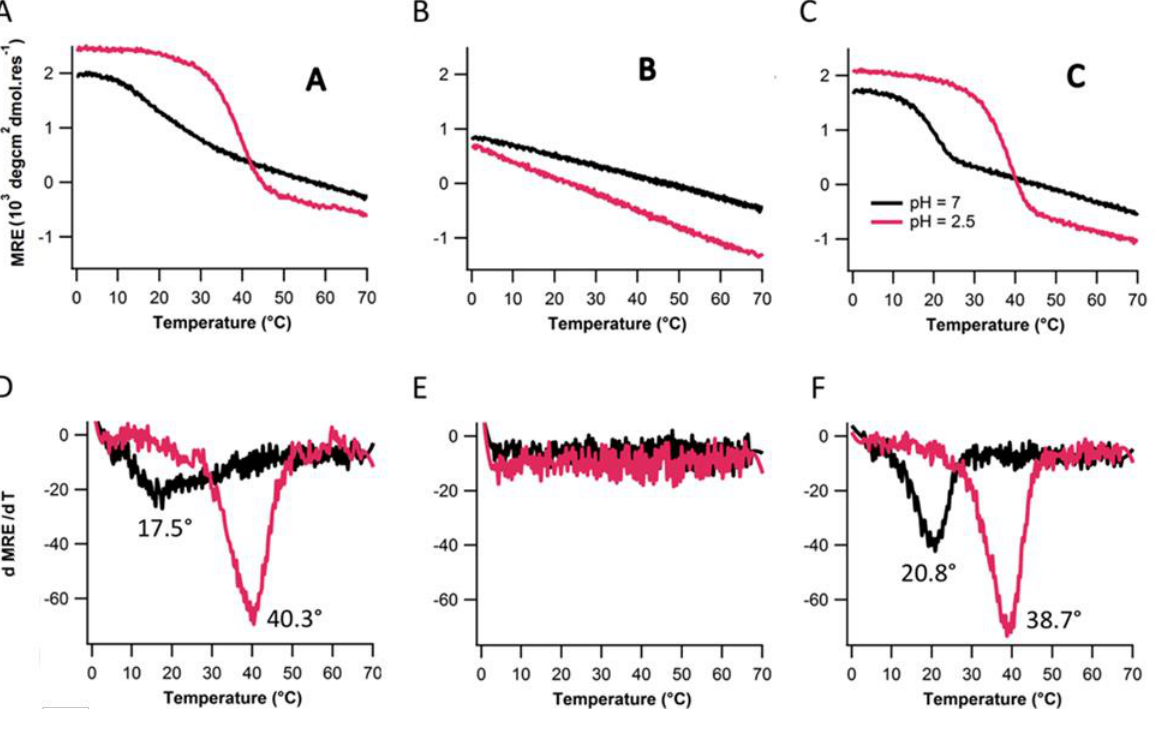
Figure 5. Thermal denaturation (top row) and their respective first derivative plots (bottom row) for A, B and C pH7 and